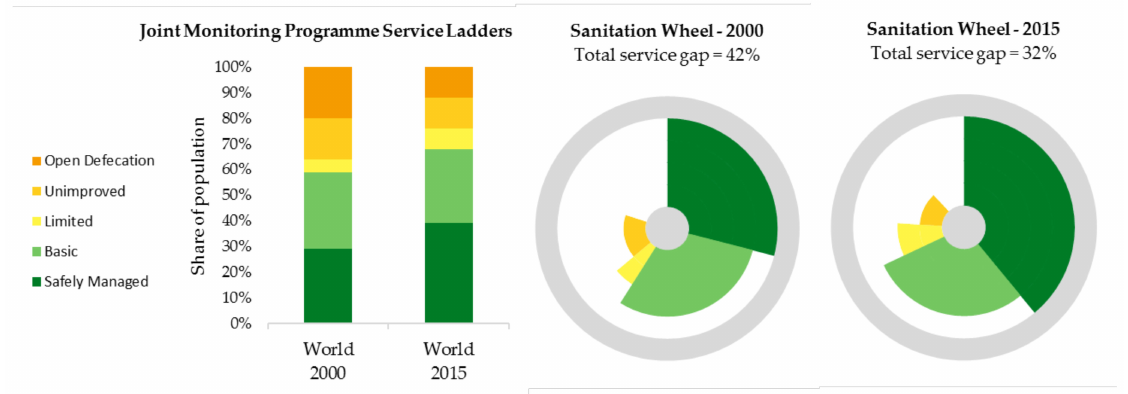
Figure 2. Comparing the JMP service ladder with the ‘Sanitation Wheel’, using estimates of global sanitation services in 2000 and